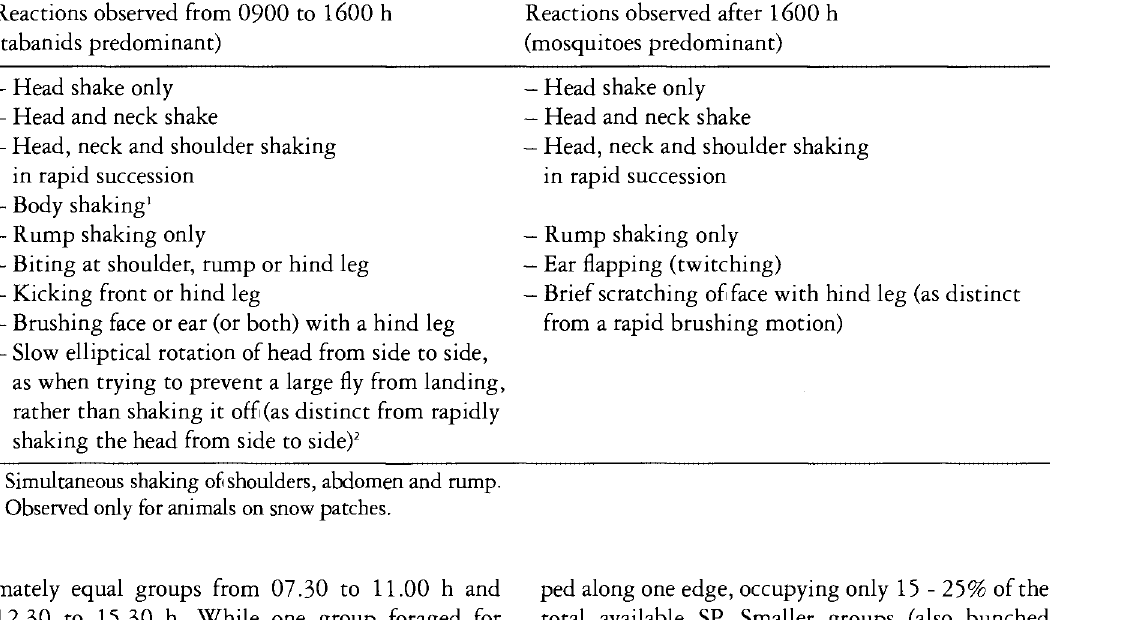
Table 6. Reindeer defensive anti-fly behavioral reactions to observed and inferred insect harassmenr. Reactions observed from 0900 to 1600